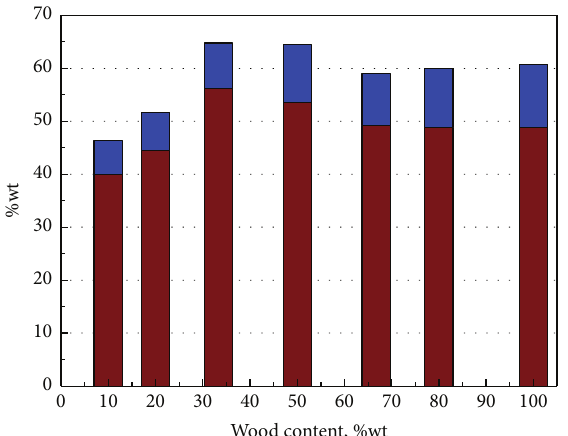
Figure 3: The yield of liquid products at the FC of wood. The brown column, in flask (8), the blue column, in flasks (10) and